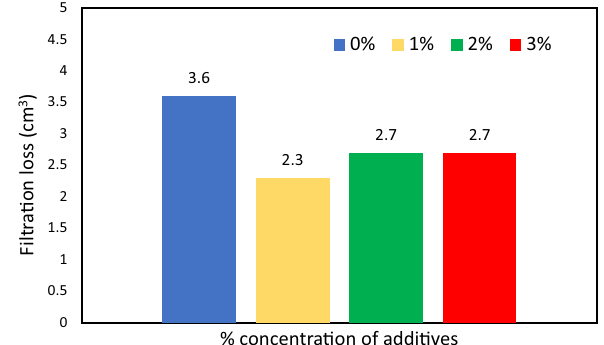
Fig. 12 Filtration loss as a function of additive